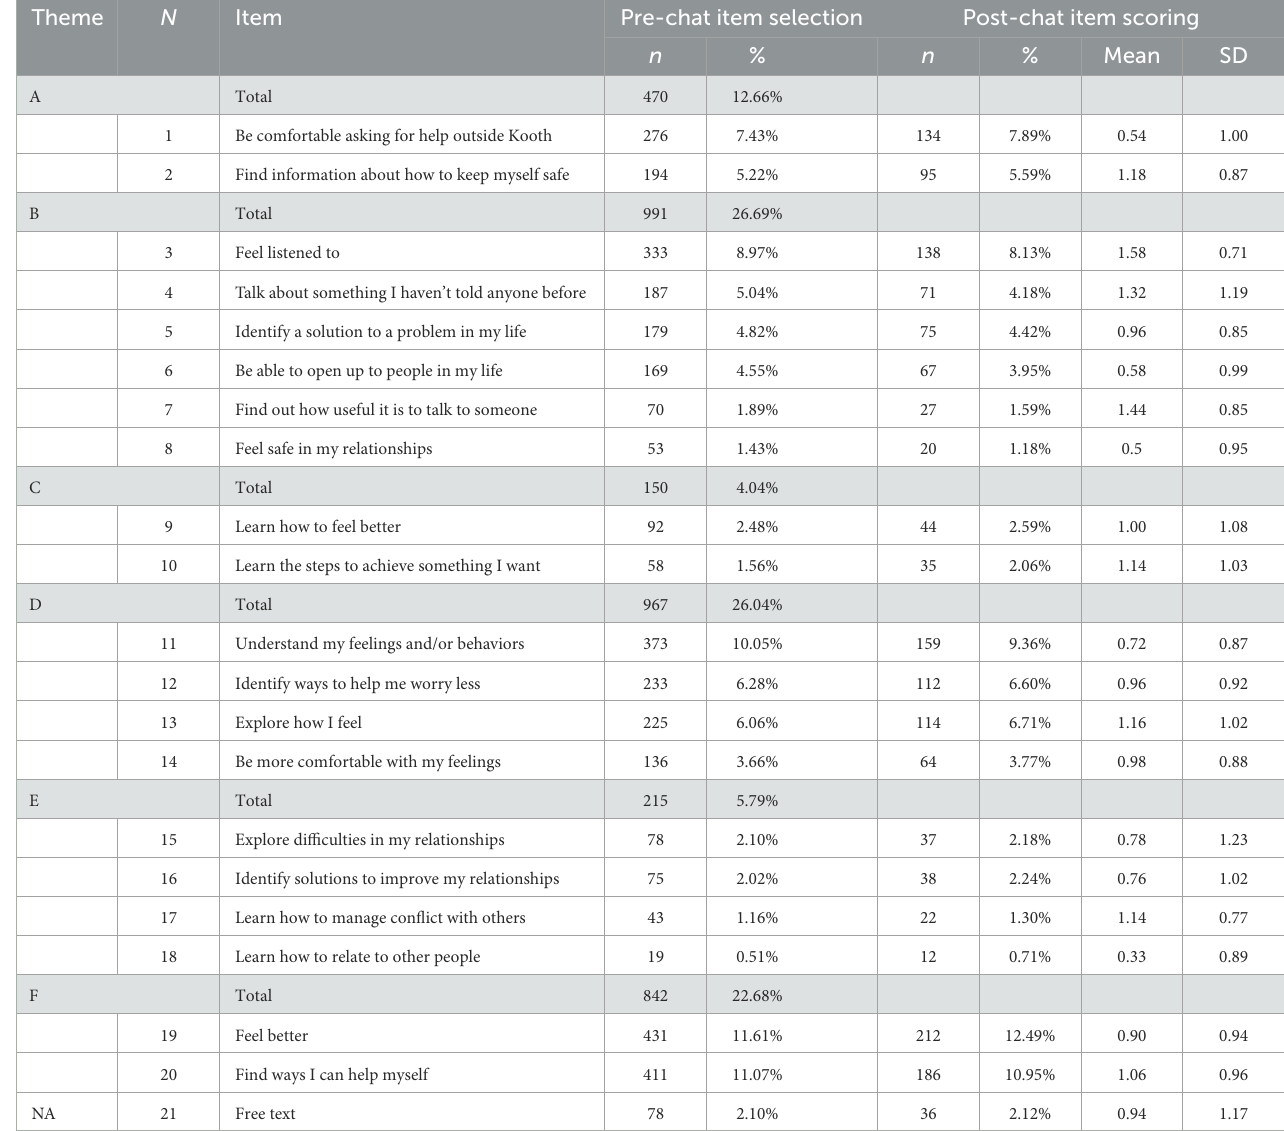
TABLE 2 SWAN-OM item selection frequencies, pre-post completion rates, and item average scores ab .